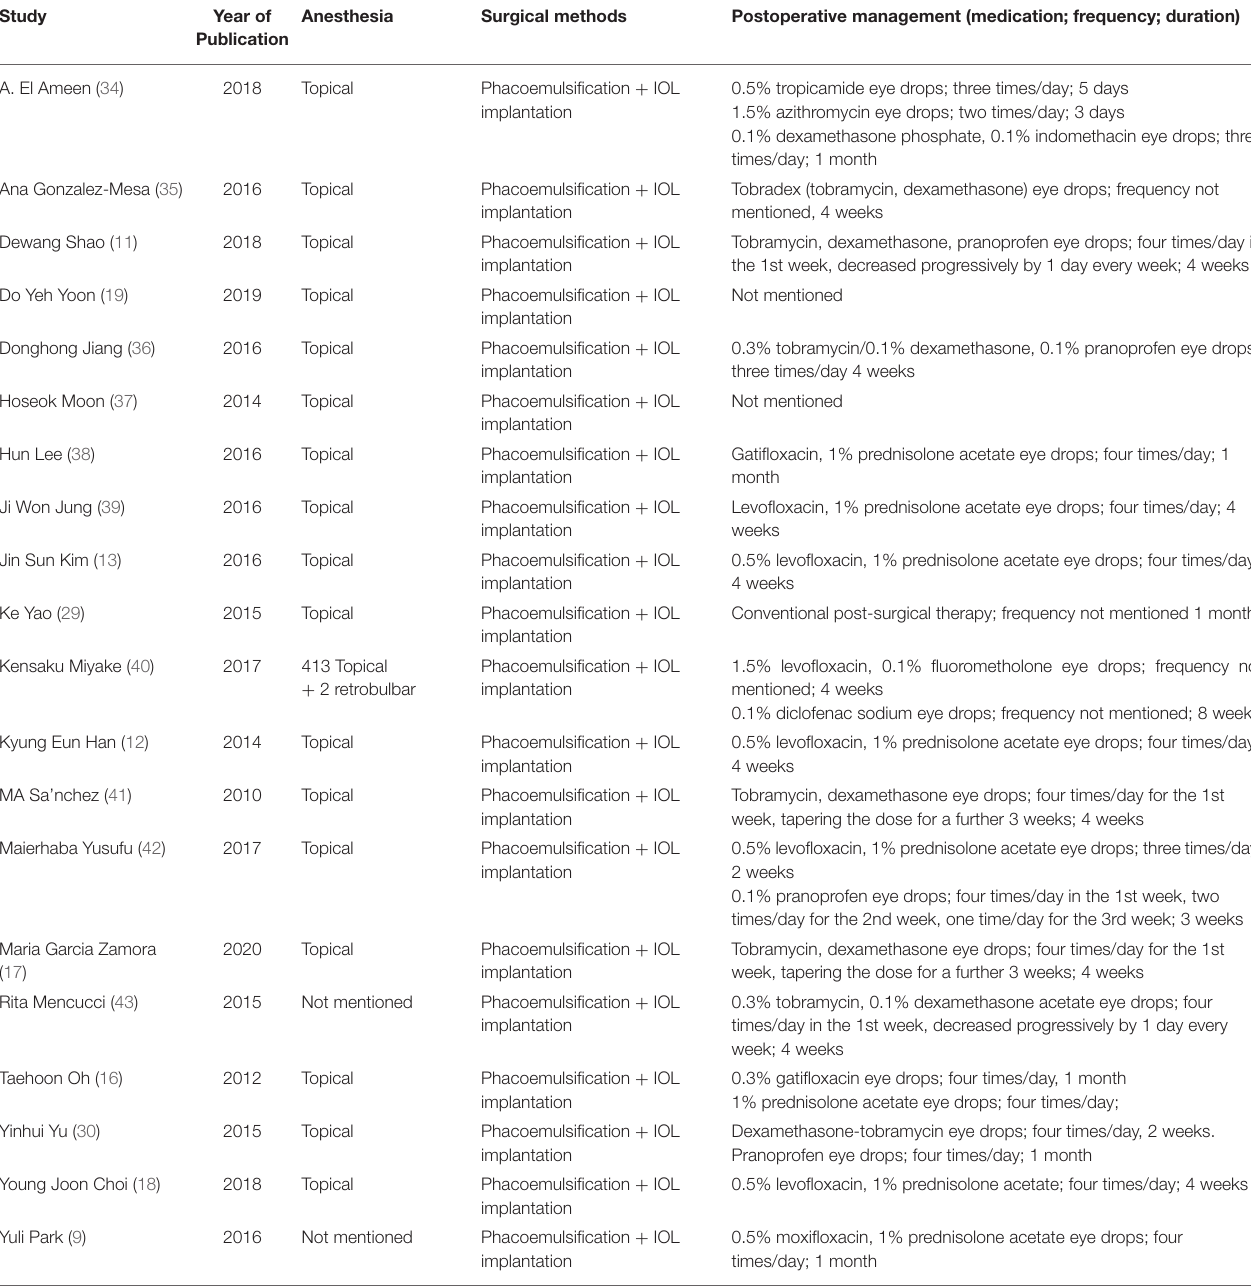
TABLE 3 | Surgical methods and postoperative management. Study